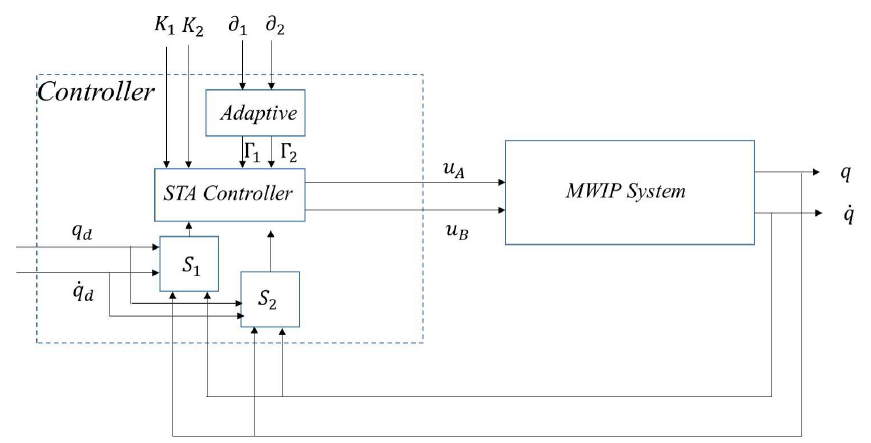
Figure 2. The diagram of the control strategy. STA—super-twisting